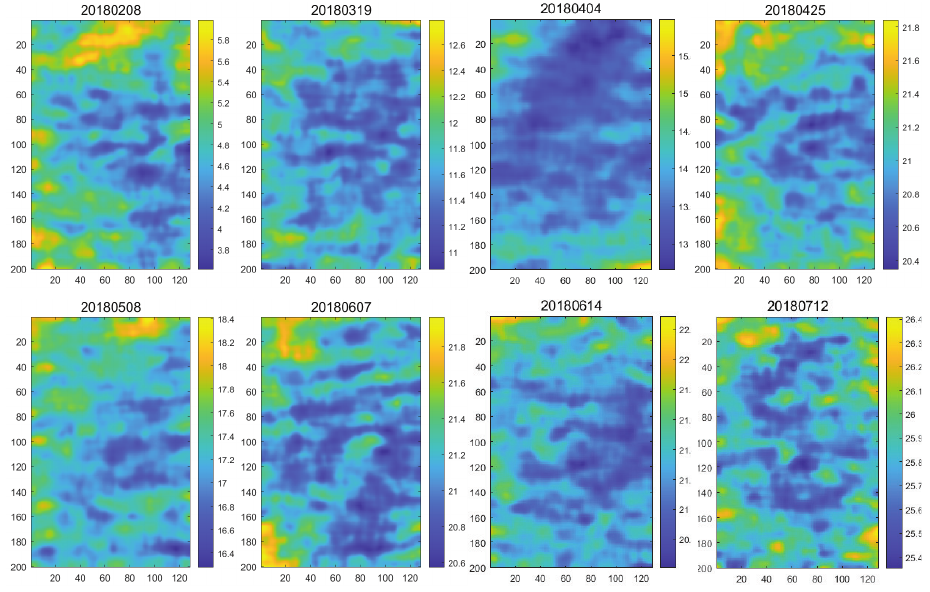
Figure 22. Examples of air temperature images measured by the proposed VisualAT method for different months (from February